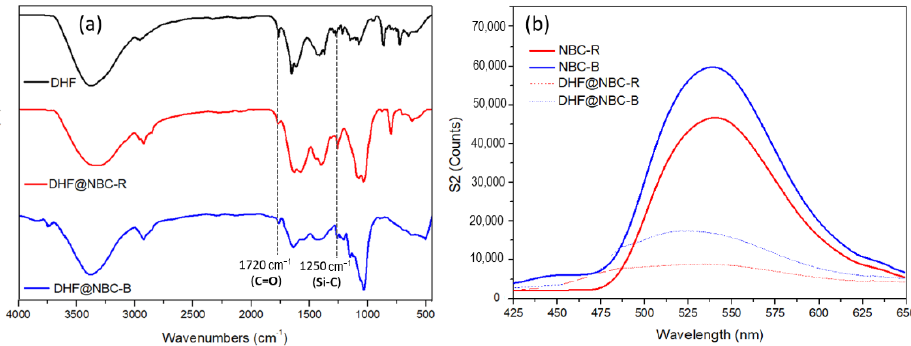
Figure 10. ( a ) FTIR spectra of DHF and of the drug-conjugated samples DHF@NBC-B and DHF@NBC-R; ( b ) PL spectra of NBC-B, NBC-R, and of the drug-conjugated samples DHF@NBC-B and DHF@NBC-R at the excitation wavelength of 360 nm and at the concentration of 100 ng/mL.